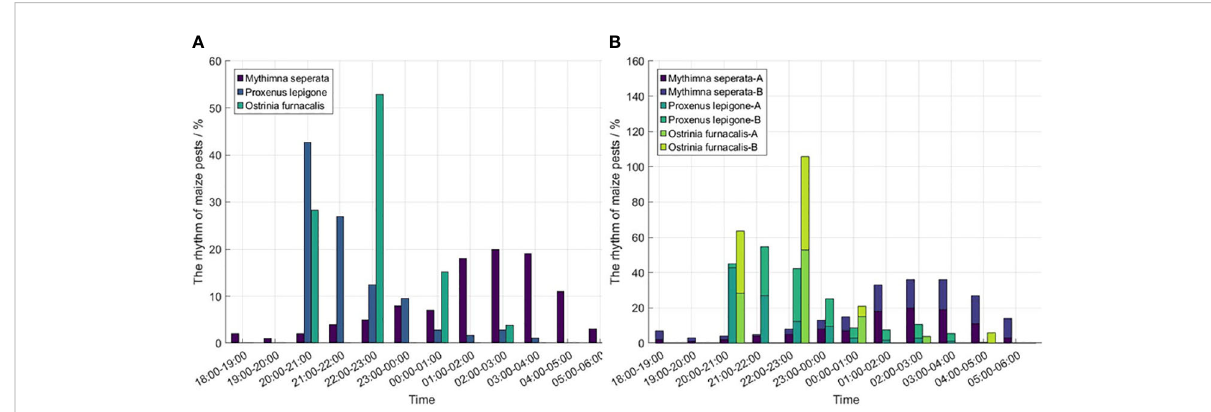
FIGURE 4 The phototactic rhythm of maize pests. (A) The phototactic rhythm of maize pests during the same period, (B) The cumulative phototactic rhythm of maize pests in different periods. (Mythimna Seperata A - 2014, Mythimna Seperata B - 2015, Proxenus Lepigone A - 2011.5.9,